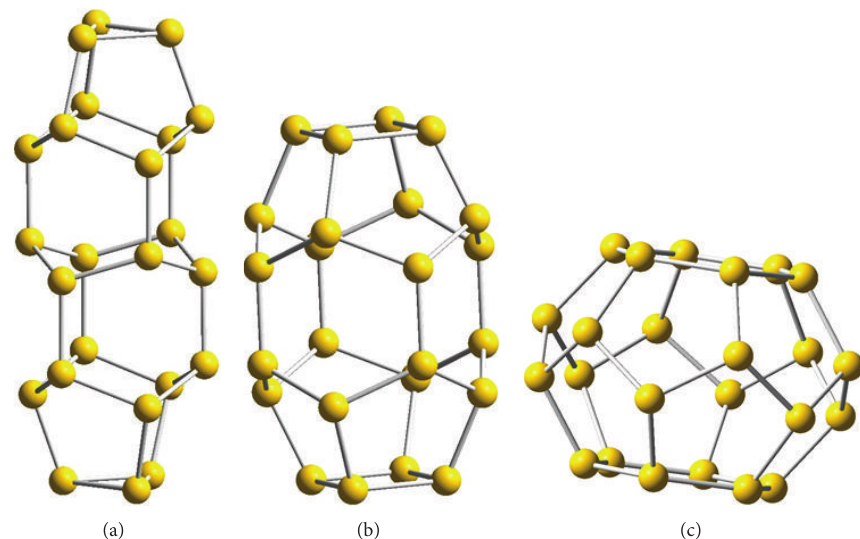
Figure 1: Isomers of N 24 : (a) triangular (T) isomer, (b) square (S) isomer, and (c) hexagonal (H) isomer.